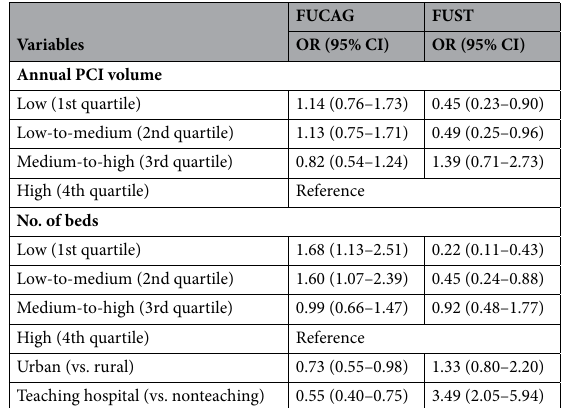
Table 3. Hospital factors associated with follow-up strategy after percutaneous coronary intervention. CI confidence interval, FUCAG follow-up invasive coronary angiography, FUST follow-up stress testing, OR odds ratio, PCI percutaneous coronary intervention.